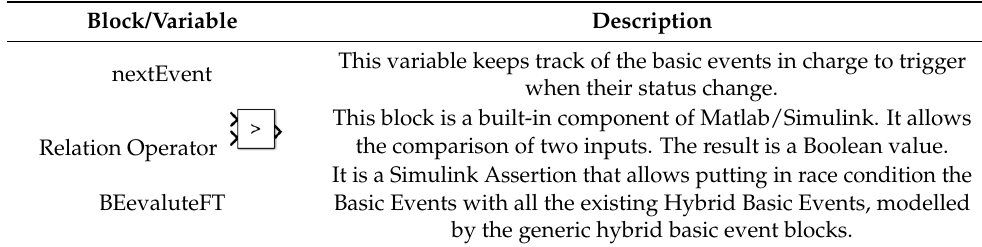
Table 2. Main elements of the “race condition” block.